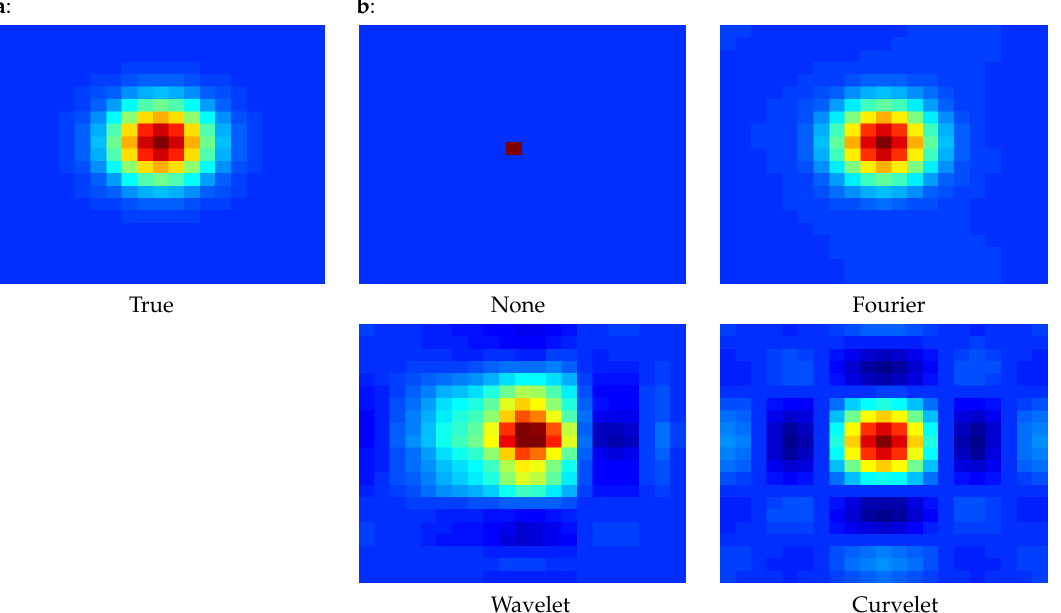
Figure 1. Correlation of the central observation point with respect to its neighbors. Dark red indicates values close to 1, blue is 0. ( a ) true correlation that we are trying to reproduce. ( b ) correlations obtained with the combination of a diagonal matrix and four different changes of variable: none ( top left ), change into Fourier space ( top right ), change into wavelet space ( bottom left ), change into curvelet space ( bottom right